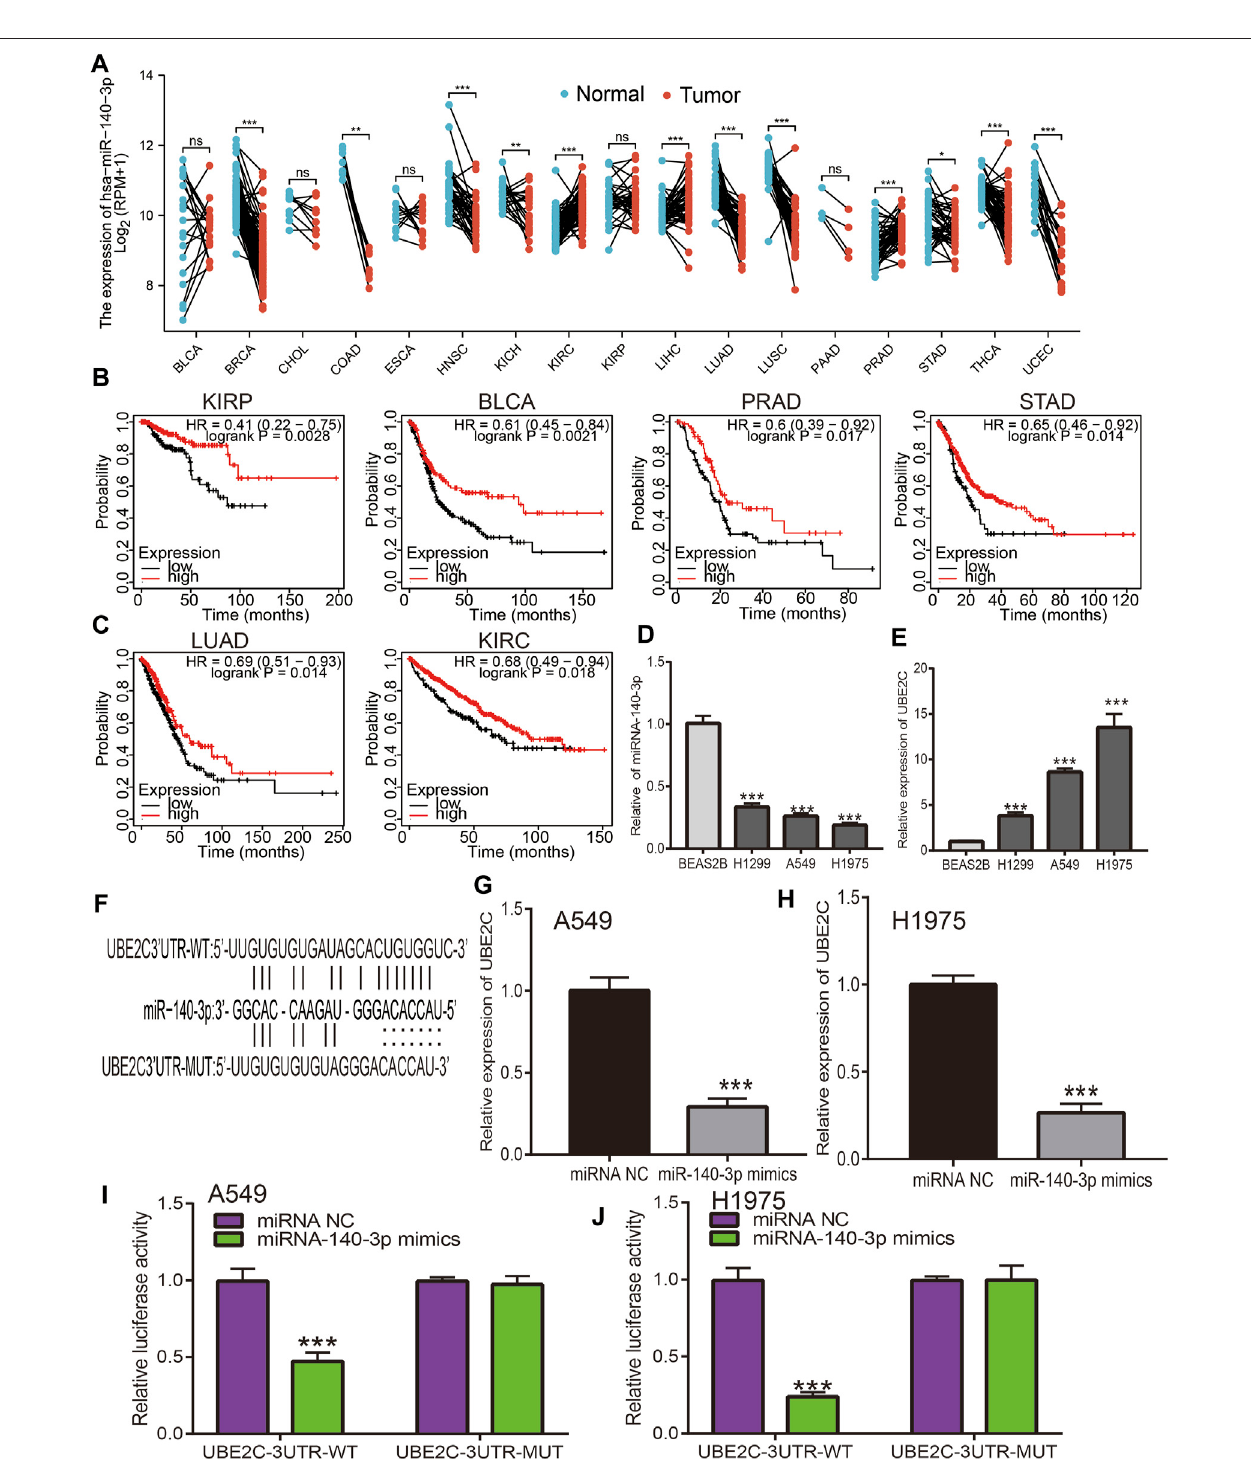
FIGURE8| Analysisoftheexpression andprognosisofmiRNA-140-3p inpan-cancer. (A) Theexpression ofmiRNA-140-3p inpan-cancers. (B,C) Theprognosis ofmiRNA-140-3pinpan-cancersexaminedbykmplotdatabase. (D,E) TheexpressionofmiRNA-140-3pandUBE2CinNSCLCcelllinesexaminedbyqRT-PCRassay. (F) The target sites between the UBE2C and miRNA-140-3p predicted by Starbase. (G,H) The expression of UBE2C after overexpression of miRNA-140-3p in NSCLC cell lines examined by qRT-PCR assay. (I,J) Relative luciferase activities of wild-type (WT) and mutated (MUT) UBE2C-3UTR reporter plasmid in A549 and H1975 cells co-transfected with miR-140-3p mimics examined by luciferase reporter assay. * p < 0.05, ** p < 0.01, *** p < 0.001.